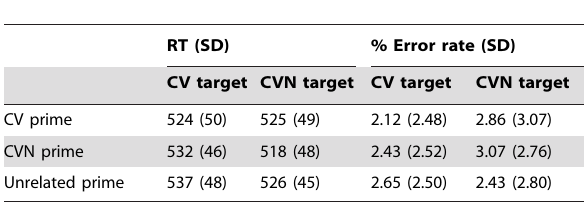
Table 6. Mean naming latencies (in ms) and mean percentage of errors (%) with standard deviation in parentheses in Experiment